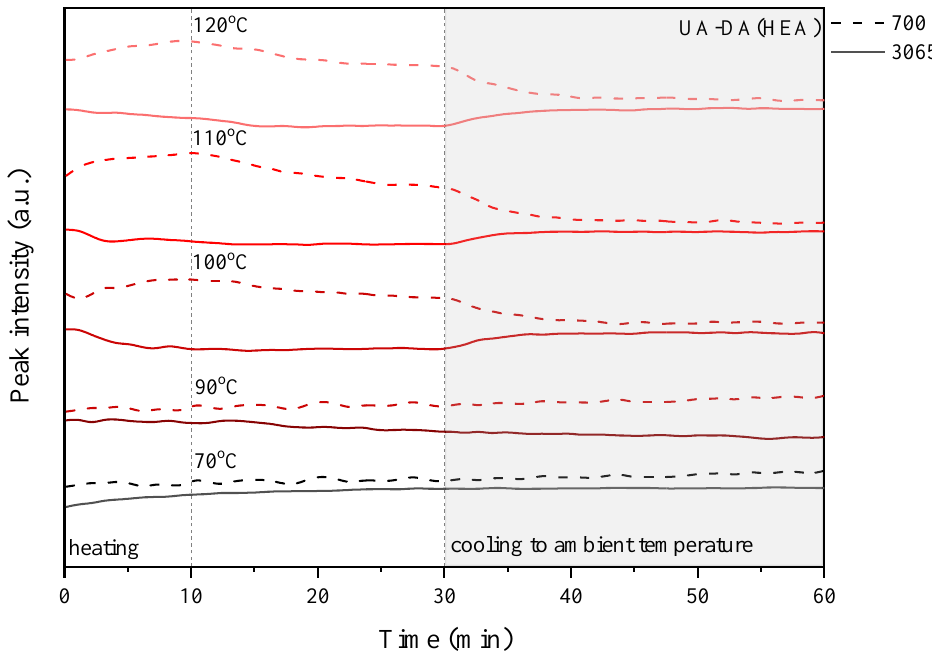
Figure 10. Change in the relative height of selected peaks based on the three-dimensional FTIR spectrum observed during the heating – thermostat – cooling cycle for the UV-cured UA-DA(HEA) sample.